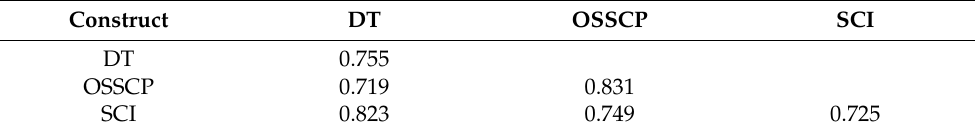
Table 3. Fornell–Larcker criterion.